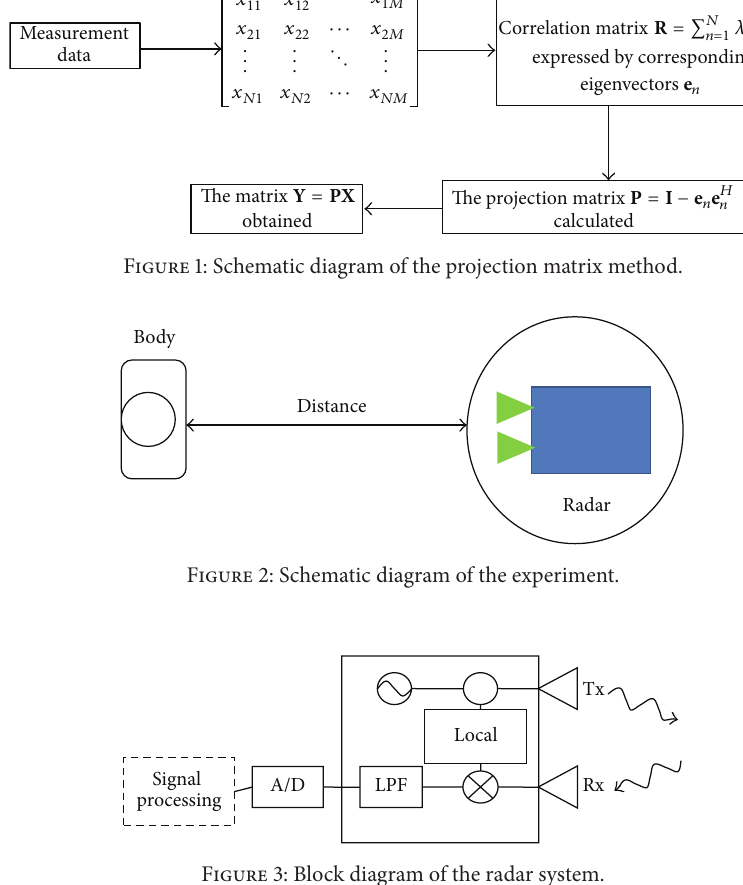
Figure 3: Block diagram of the radar